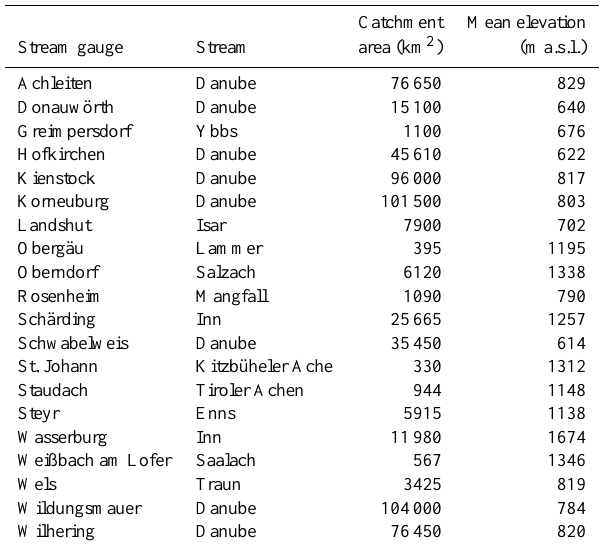
Table A1. Catchment area and mean elevation of the catchments used in this paper (Fig.